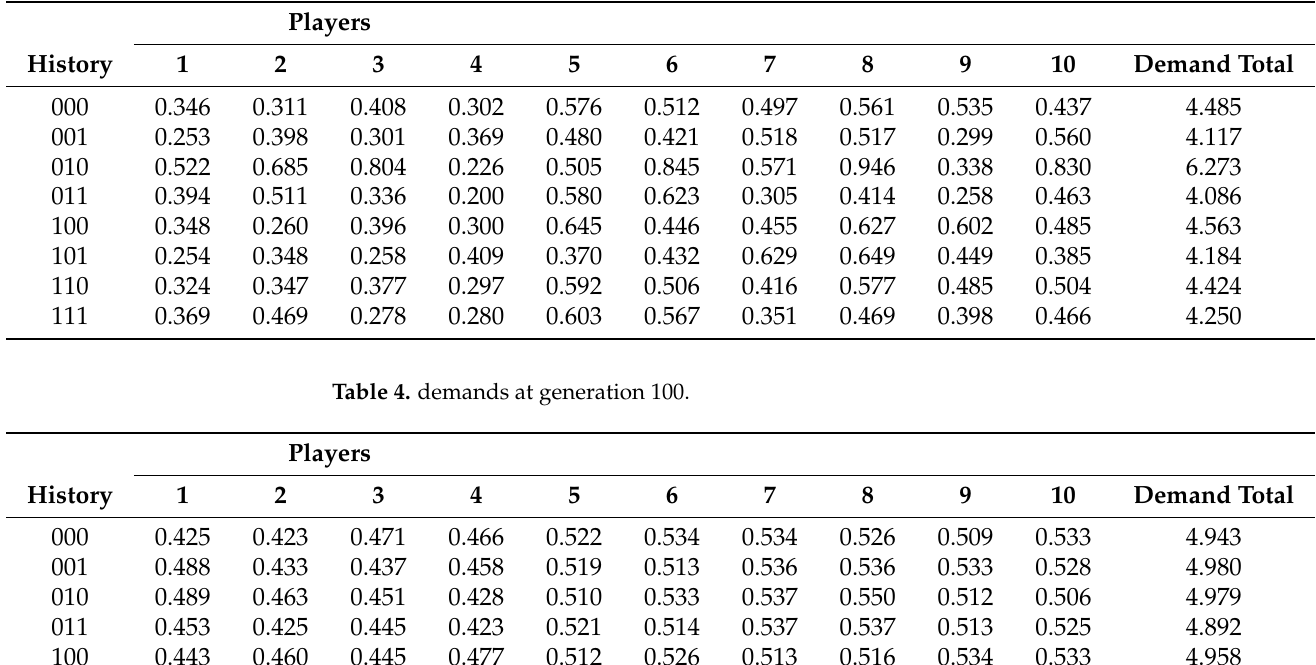
Table 3. demands at generation 10.